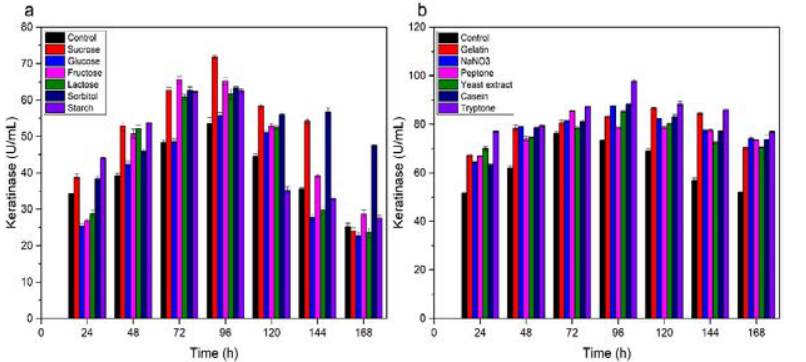
Fig. 3. Keratinase activity during growth of A. chroococcum B4 on chicken feathers supplemented with different C- and N- sources. (a) C- source. (b) N-source. Values are the means ± SD of three replicates.